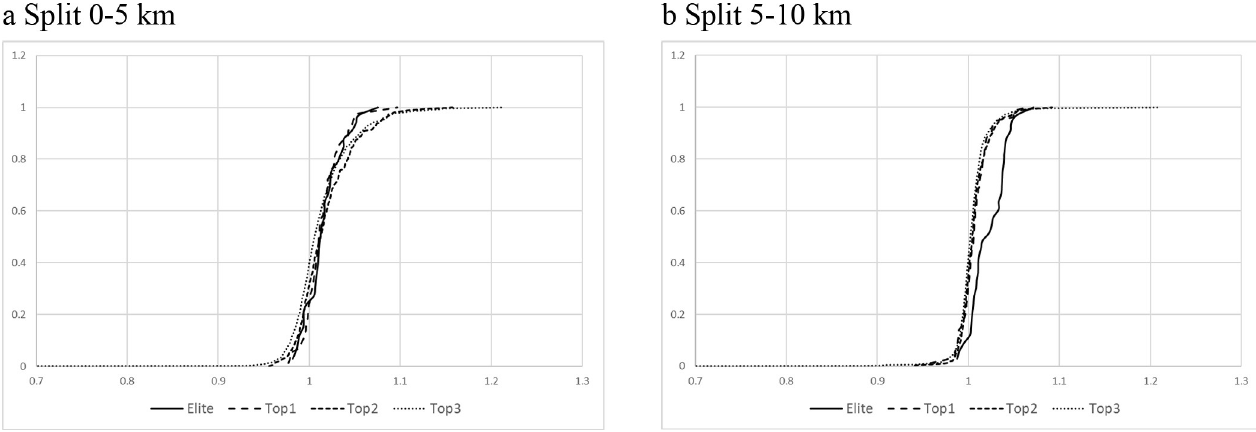
Fig 3. Competition profile of the male athletes in splits with significant differences between groups. “X” axis: standardized velocity; “Y” axis: relative frequency. A standardized velocity of "1" represent the mean velocity of the athletes in the marathon.